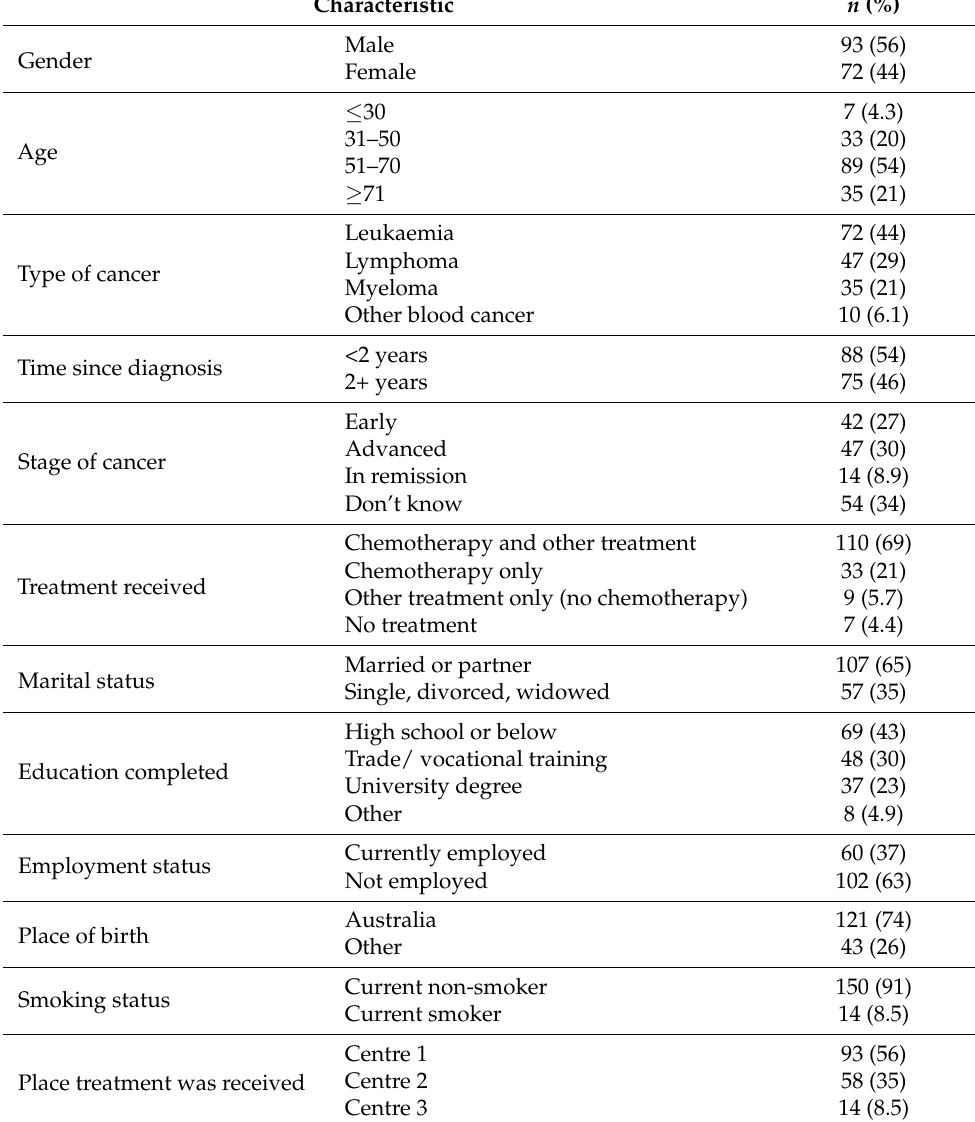
Table 1. Socio-demographic and disease characteristics of the study sample ( n =